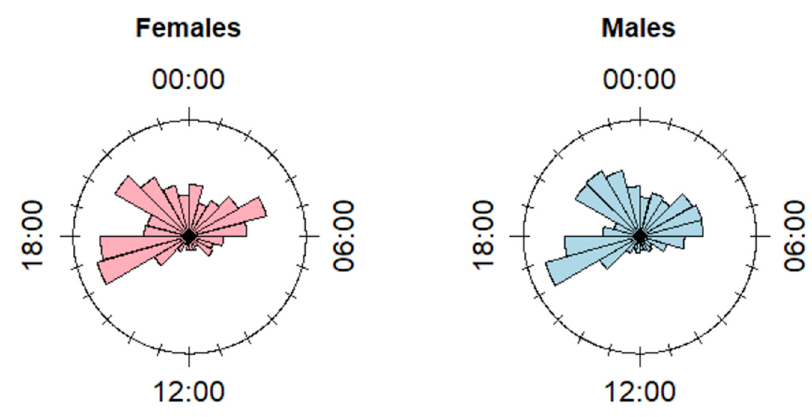
Figure 1. Rose diagrams displaying the circular distribution of the daily modes of the timestamps of the pictures detecting roe deer at FS, divided by sex. Hours shown in